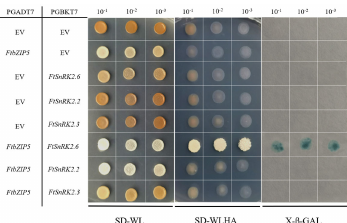
Figure 11. Y2H experiment used to analyze the relationship between FtSnRK2.6 / 2.3 / 2.2 and FtbZIP5. The combination plasmid transformed in AH109 yeast cells were serially diluted 10-, 100- and 1000-fold, cultured on SD / -Trp-Leu medium and SD / -Trp- \ Leu-His-Ade medium, respectively, and then stained with x- β